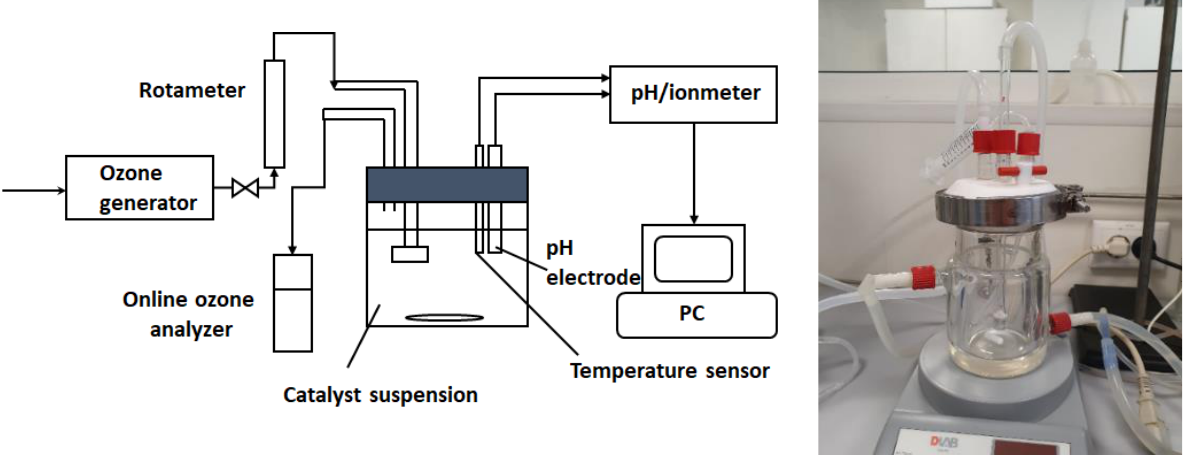
Figure 1. Experimental set – up used for catalytic ozonation processes.